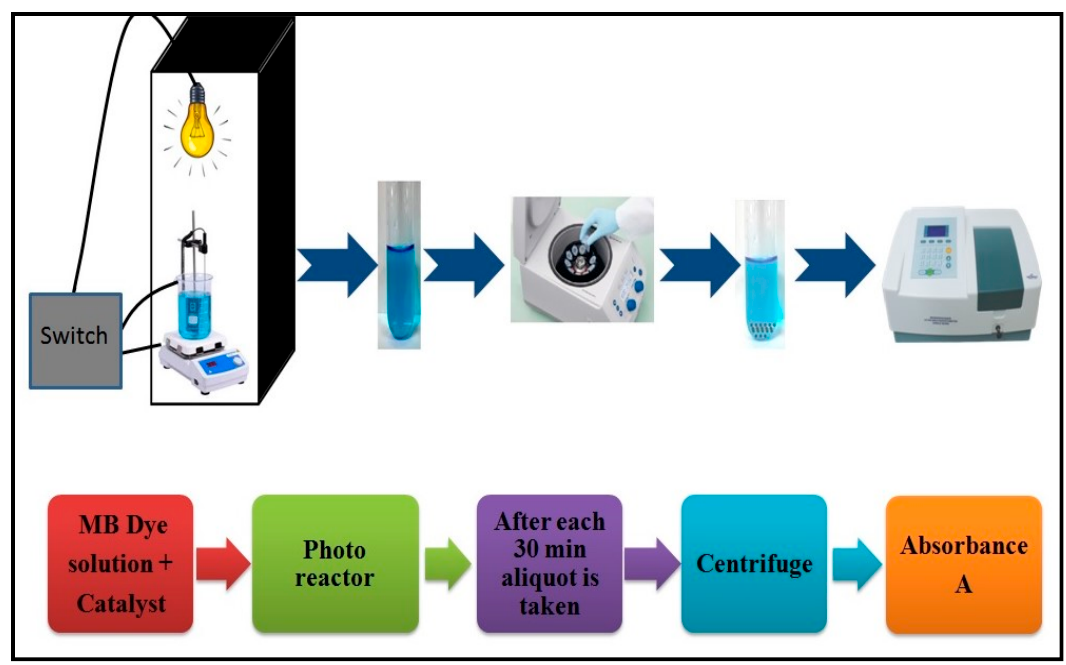
Figure 1. Schematic representation of photocatalytic degradation of dye.